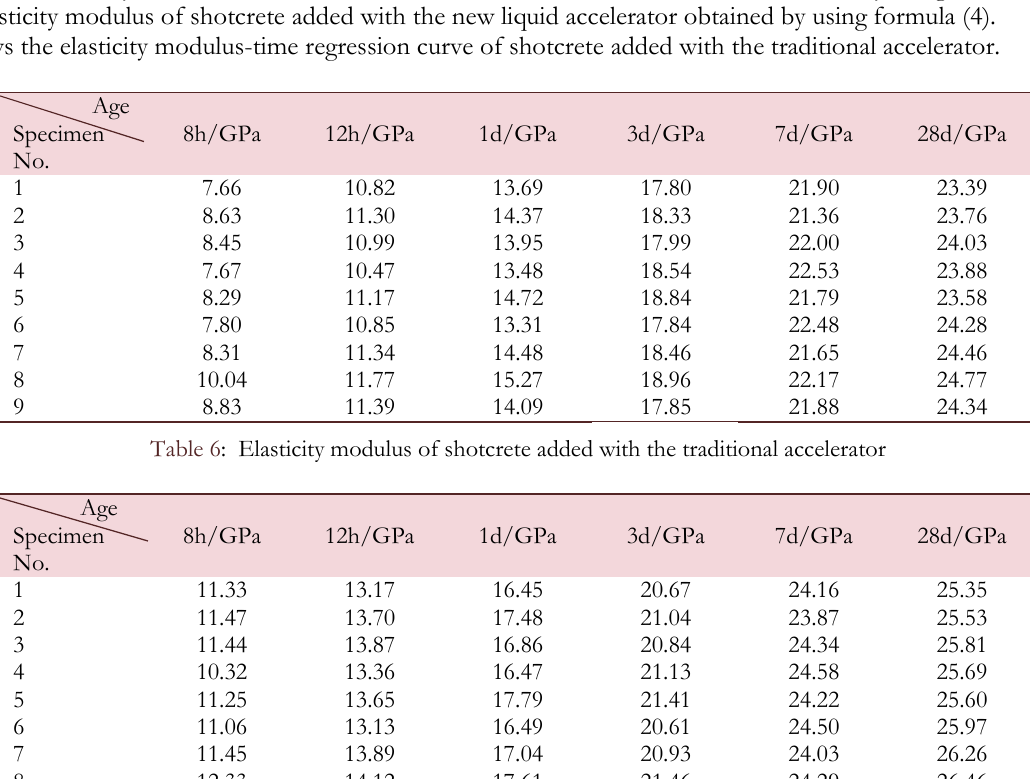
Tab. 6 lists the elasticity modulus of shotcrete added with the traditional accelerator obtained by using formula (4). Tab. 7 lists the elasticity modulus of shotcrete added with the new liquid accelerator obtained by using formula (4). Fig. 4 shows the elasticity modulus-time regression curve of shotcrete added with the traditional accelerator.